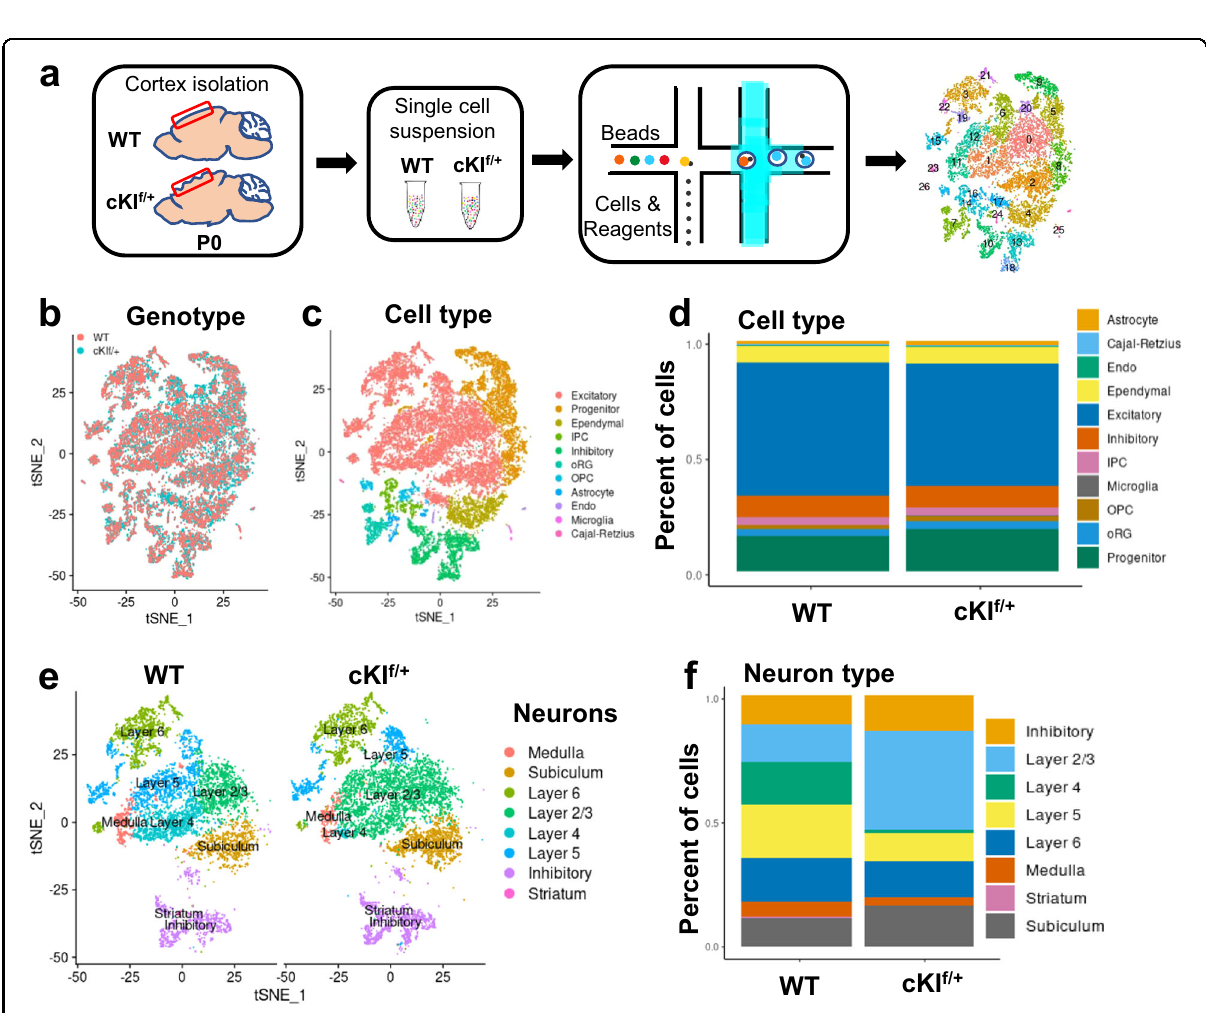
cell types. Different clusters of neuronal cells were cal- culated through the unsupervised clustering method (Supplementary Fig. S4f). The supervised cell-type